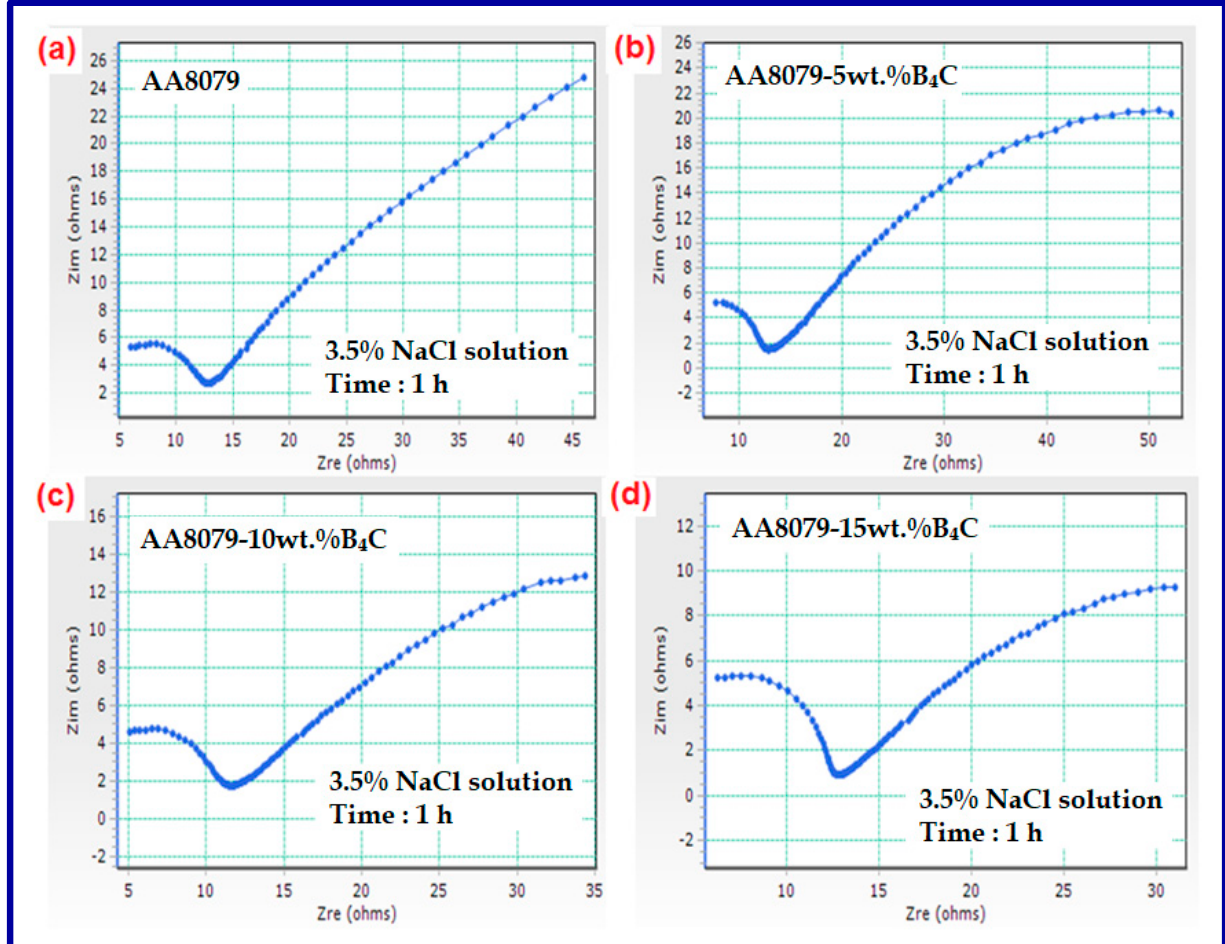
Figure 12 . ( a – d ) Nyquist plots for ( a ) AA8079, ( b ) AA8079-5wt.%B 4 C, ( c ) AA8079-10wt.%B 4 C, and ( d ) AA8079-15wt.%B 4 C Figure 12. ( a – d ) Nyquist plots for ( a ) AA8079, ( b ) AA8079-5 wt.%B 4 C, ( c ) AA8079-10 wt.%B 4 C, and ( d ) AA8079-15 wt.%B 4 C composites in 3.5%NaCl solutions. composites in 3.5%NaCl